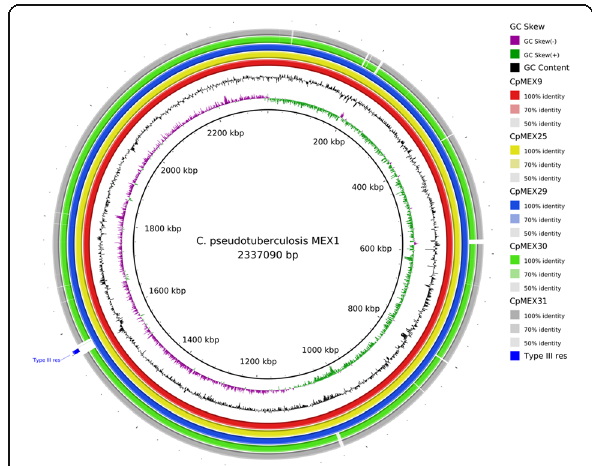
Fig. 2 Circular map of C. pseudotuberculosis strain MEX1 (biovar ovis ) in comparison with the other strains of this study. The cluster of methylation type III, which is only present in biovar ovis strains, is highlighted in blue